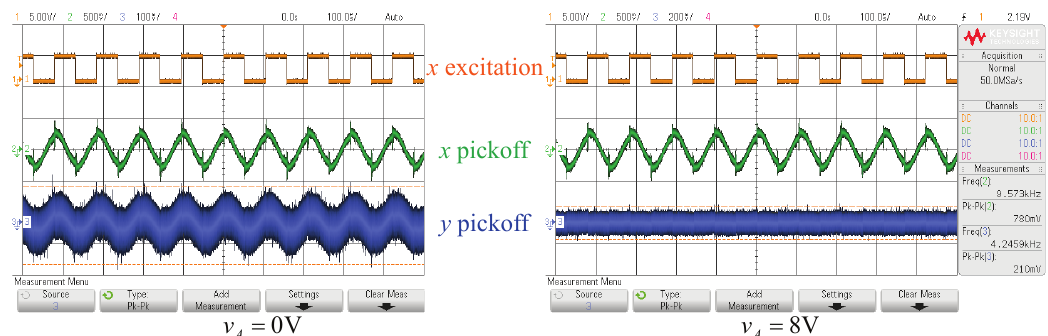
Figure 15. The quadrature signals before and after the quadrature